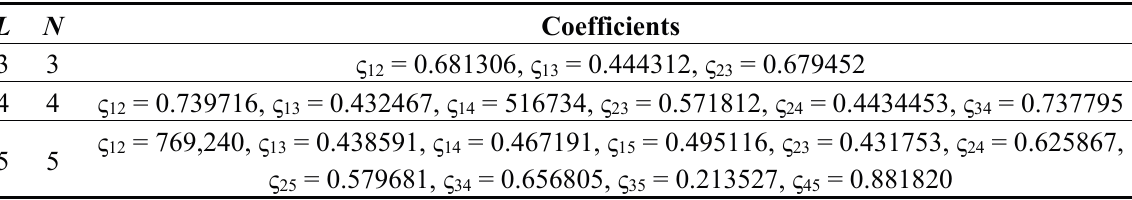
Old Table 10. LMSuc algorithm coefficients.